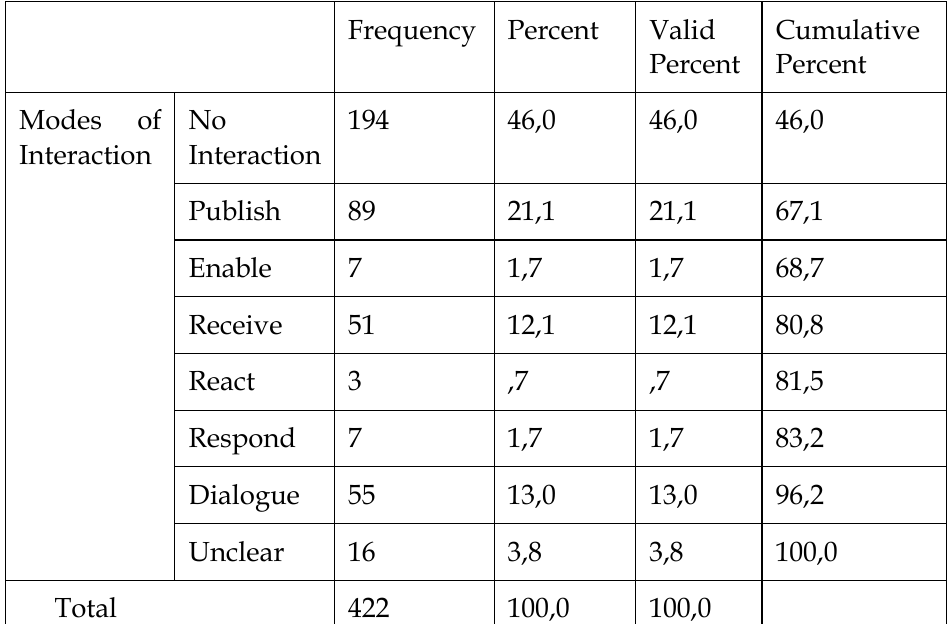
Table 3: Frequency of Modes of Interaction